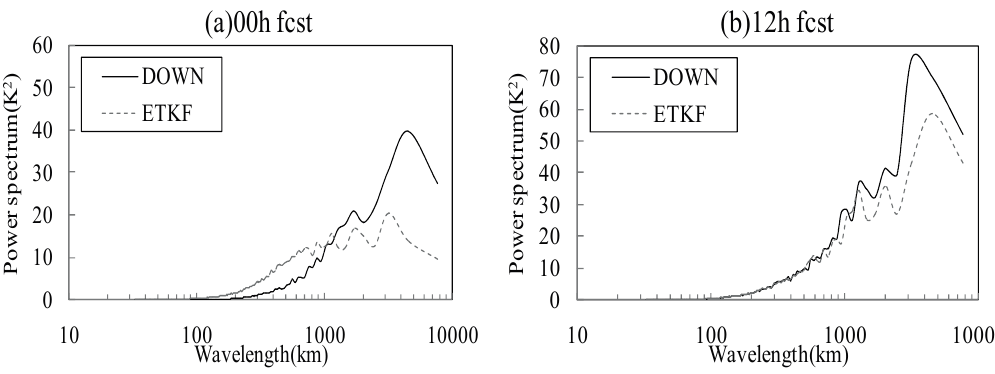
Figure 2. All member averaged power spectra of 500 hPa temperature perturbations as a function of wavelength for ETKF and DOWN. ( a ) Initial time; ( b ) 12 h forecast lead